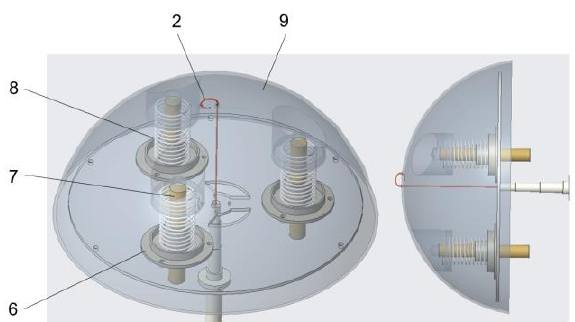
Figure 8. Diagram of the structure of the elastic potential energy storage and release. 2-rope, 6- spring base, 7-spring shaft, 8-spring, and 9-shell.